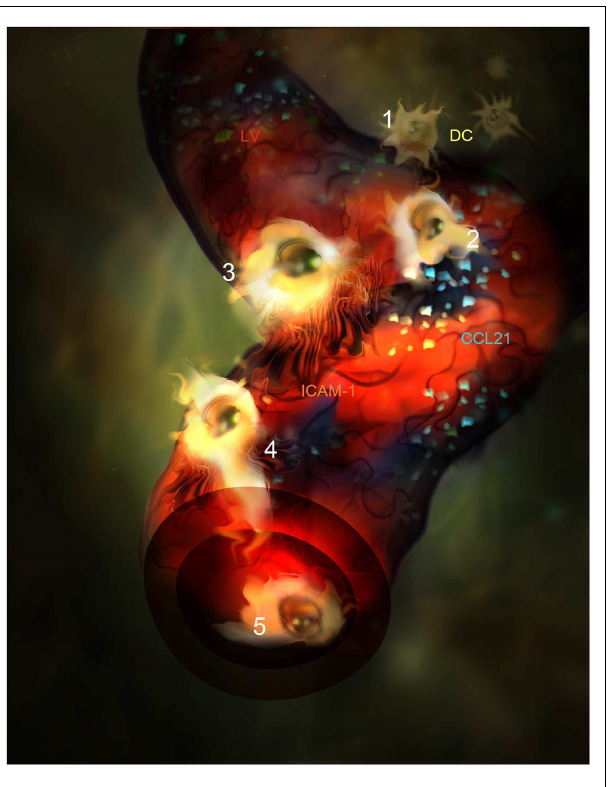
FIGURE 2 |Artistic representation of novel steps in DC migration into LVs under inflammatory conditions . (1) DC (Yellow) are attracted by CCL21 interstitial gradient and other chemokines toward LVs lined by specialized endothelial cells (red). (2) DCs dock to CCL21 (blue) adsorbed as enriched patches prior to adhesion and intravasation. (3) DCs adhere to LEC surface and get entrapped by ICAM-1 enriched microvilli projections(Orange). (4) DC intravasate in a LV accompanied by ICAM-1 enriched microvilli projections. (5) DC actively crawl inside the